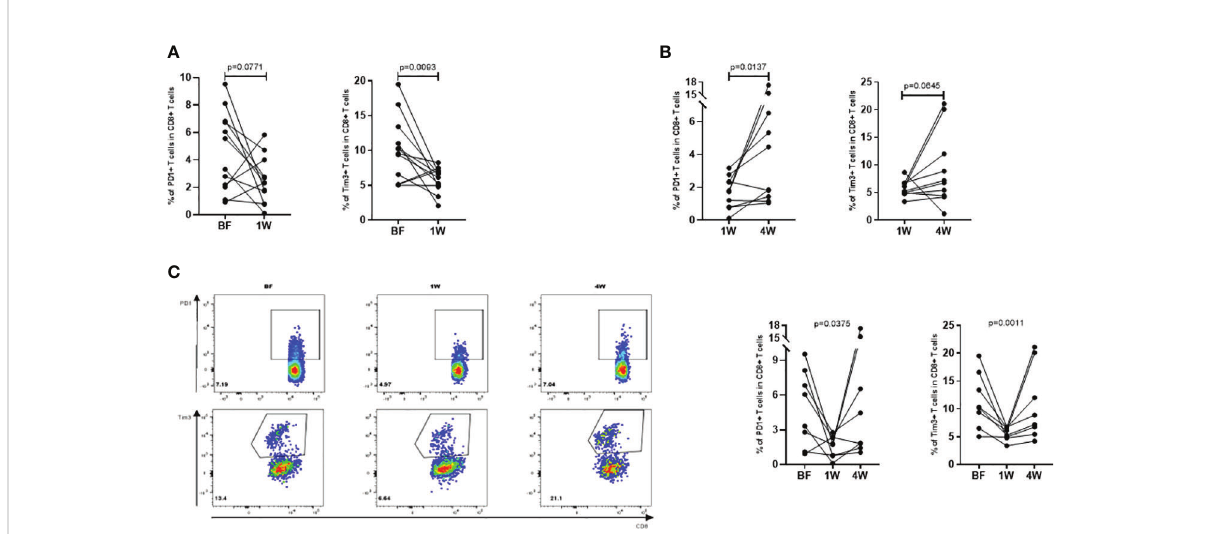
FIGURE 4 Phenotypic analysis of the TAA-speci fi c T cells at BF, 1W and 4W. (A) The BF: 1W matching analysis of the PD1+ and Tim3+ T cells in TAA- speci fi c CD8+ T cells using the culturation of T cell (n=12). (B) The 1W: 4W matching analysis of the PD1+ and Tim3+ T cells in TAA-speci fi c CD8+ T cells using the culturation of T cell (n=10). (C) The BF: 1W: 4W matching analysis of the PD1+ and Tim3+ T cells in TAA-speci fi c CD8+ T cells using the culturation of T cell (n=10). Values were compared by paired non-parametric